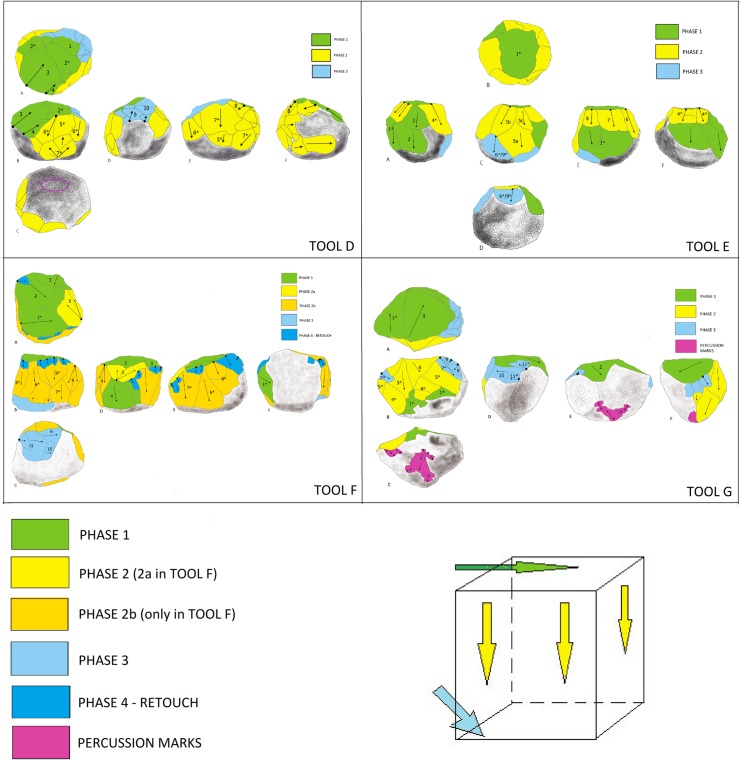
Comparison of the diacritical drawings and simplified operative scheme deduced from the diacritical lecture (cube on bottom right).